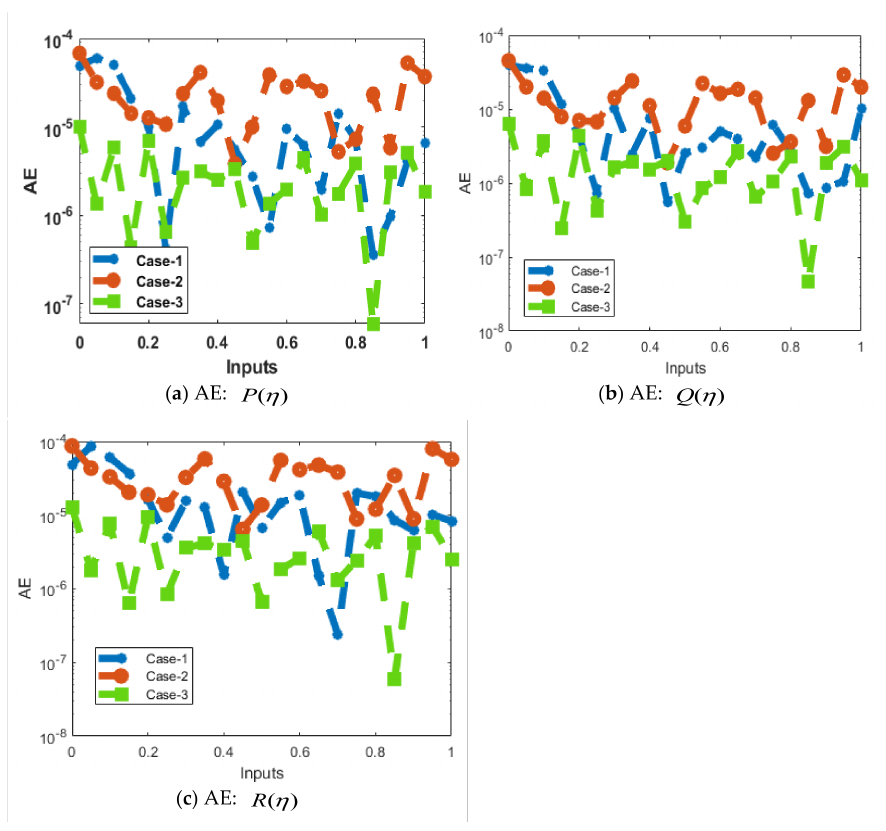
Figure 7. AE performances for the dynamical